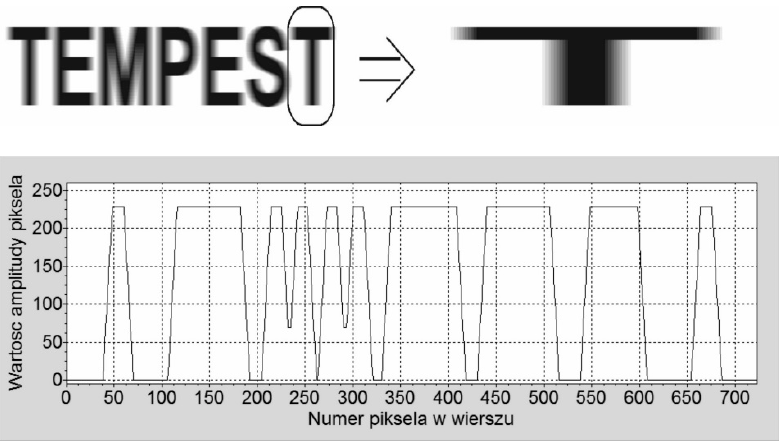
Figure 3. Application effect of a low-pass filter on the output of the VGA video